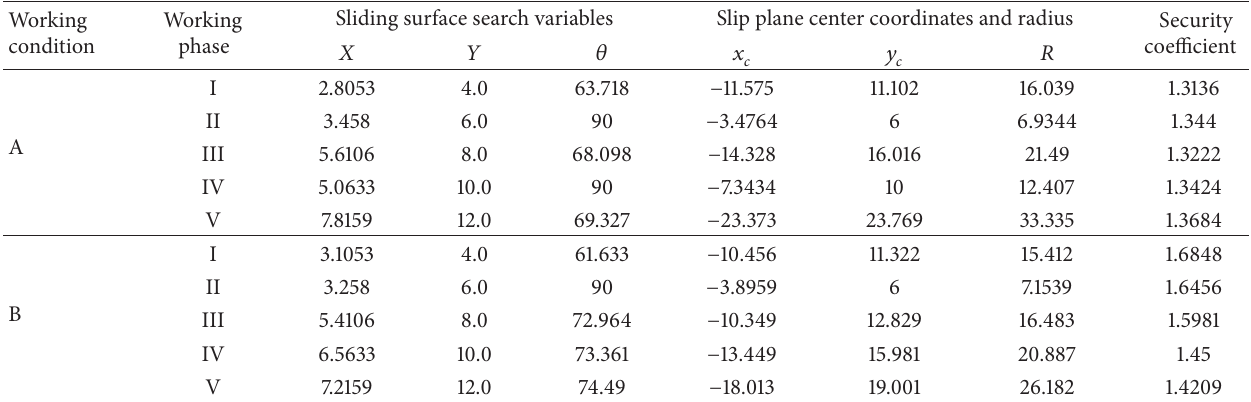
Table 4: Different condition control parameters of sliding